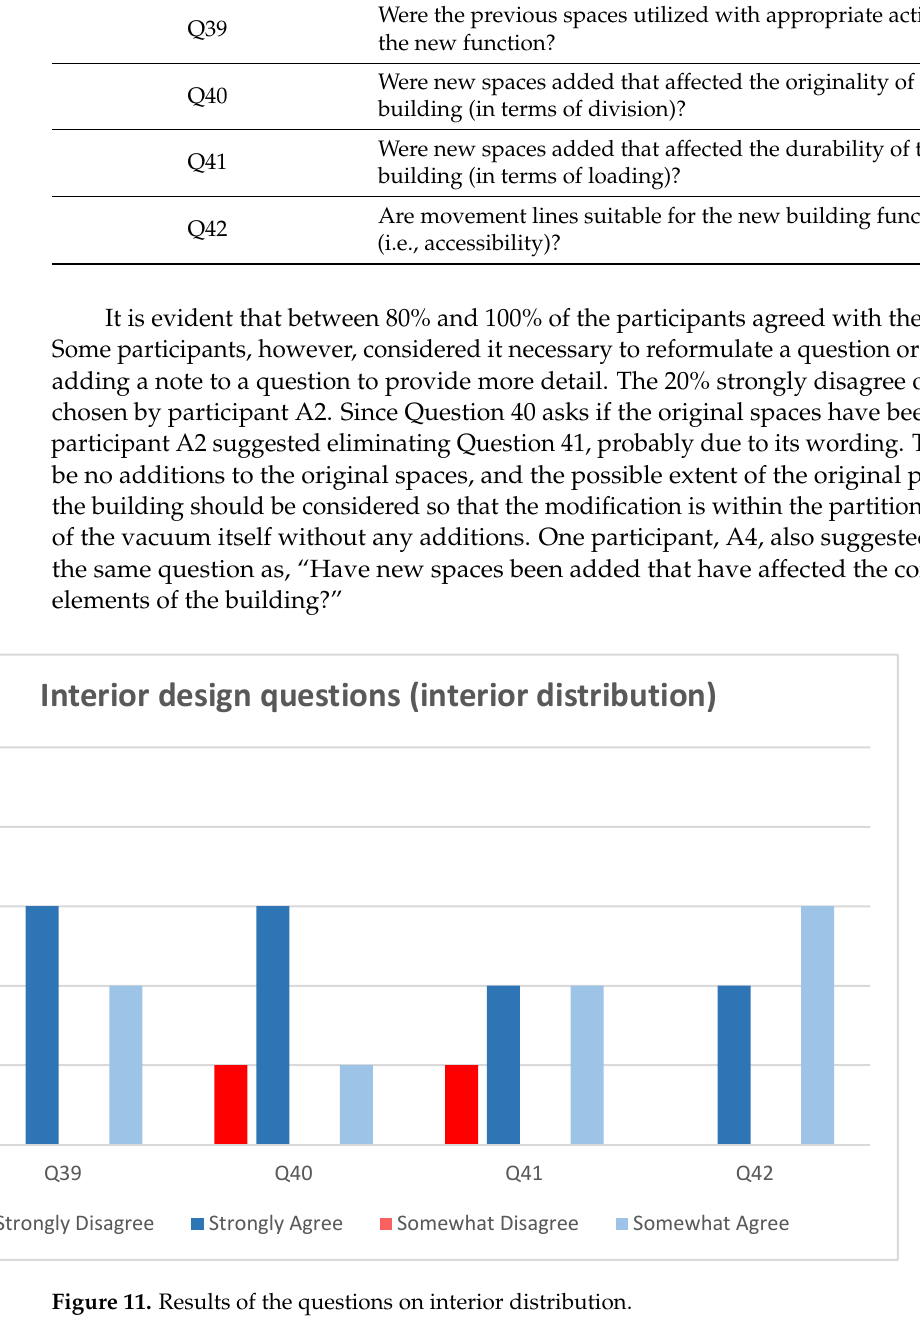
Table 7. Interior design questions (interior distribution).